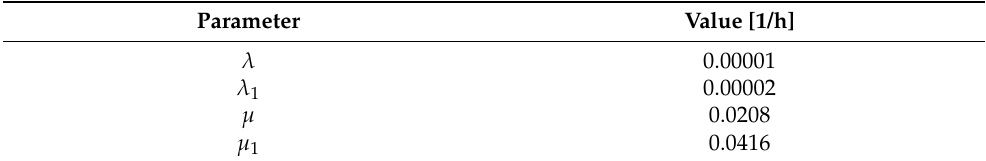
Table 1. Metrics for system dependability.